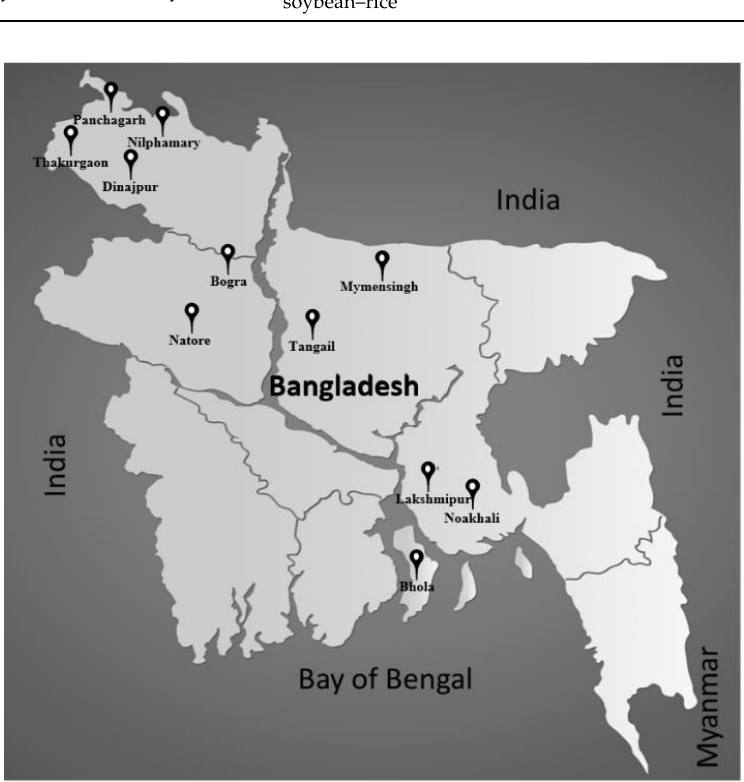
Figure 1. Map of soil sample collection sites of Bangladesh.